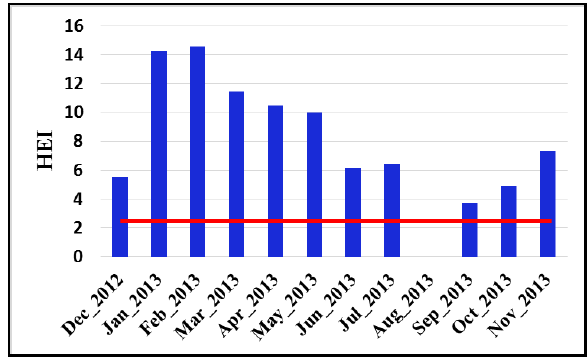
Fig. 2 Heavy metal evaluation index of Silakhor River at various sampling times